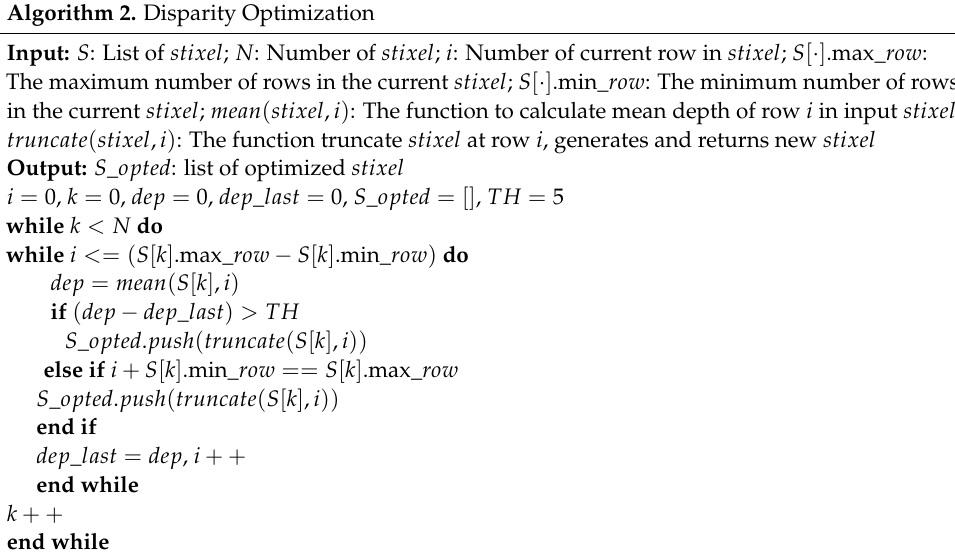
Algorithm 2. Disparity